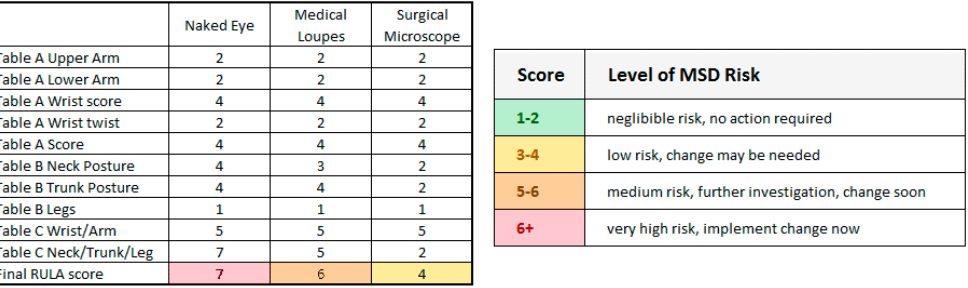
Figure 12. On the left, the different scores obtained for each body part according to the RULA table. On the right, we report the musculoskeletal disorders risk related to the final RULA Score from Table C in Figure 5.